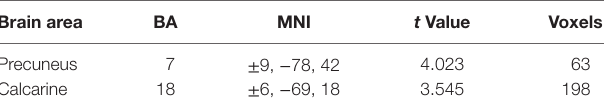
Table 2 | Brain areas with differences in voxel-mirrored homotopic connectivity between OSAHS patients and controls. brain